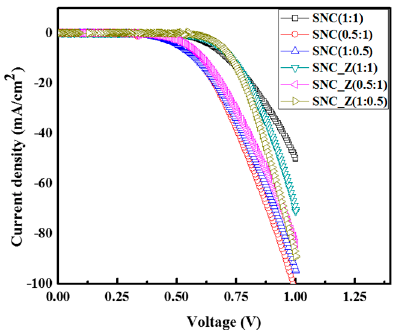
Figure 5. Dark current characteristics of the DSSCs based on different photoanodes.